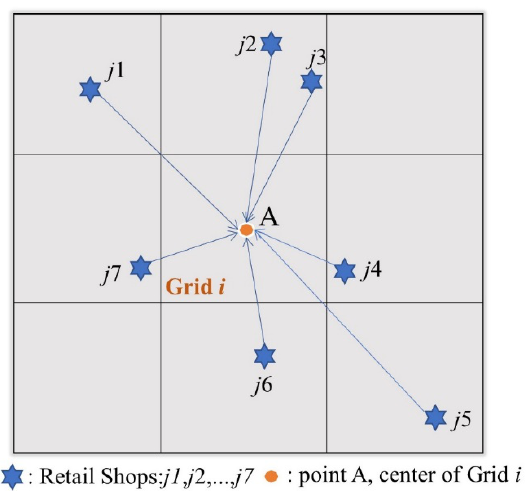
Figure 5. Principle of spatial competition index. Grid i is the basic target study area.